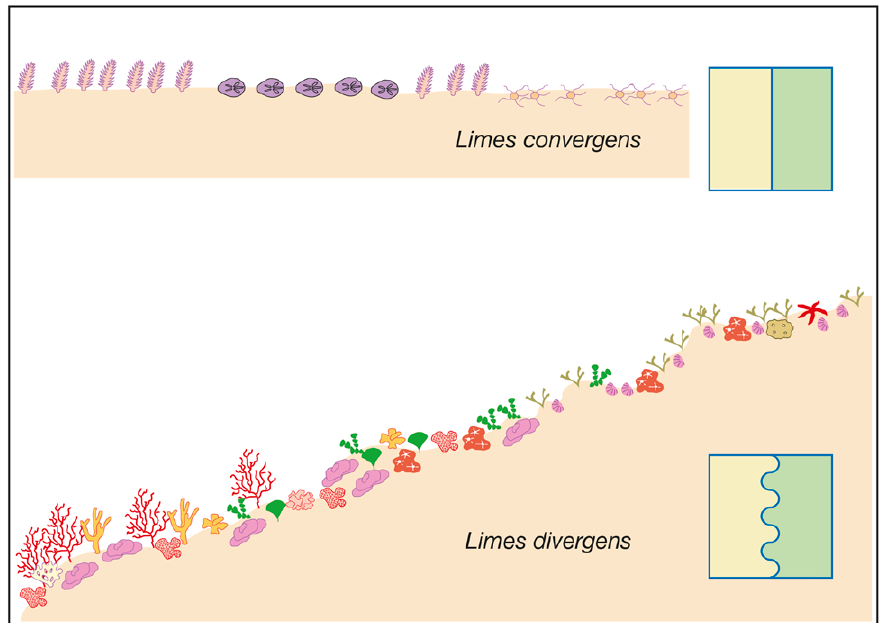
Fig. 1. – Different benthic profiles with linear, contrasting limits and low fractal limits ( limes convergens ) or sinuous, diffuse limits with a high fractal index ( limes divergens ). Redrawn from van Leeuwen